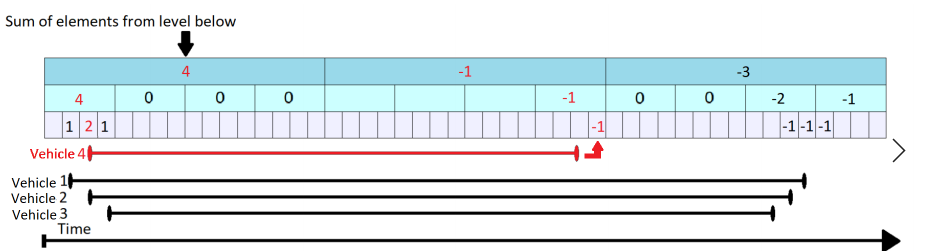
Figure 12. KEP Tree—Initial State.